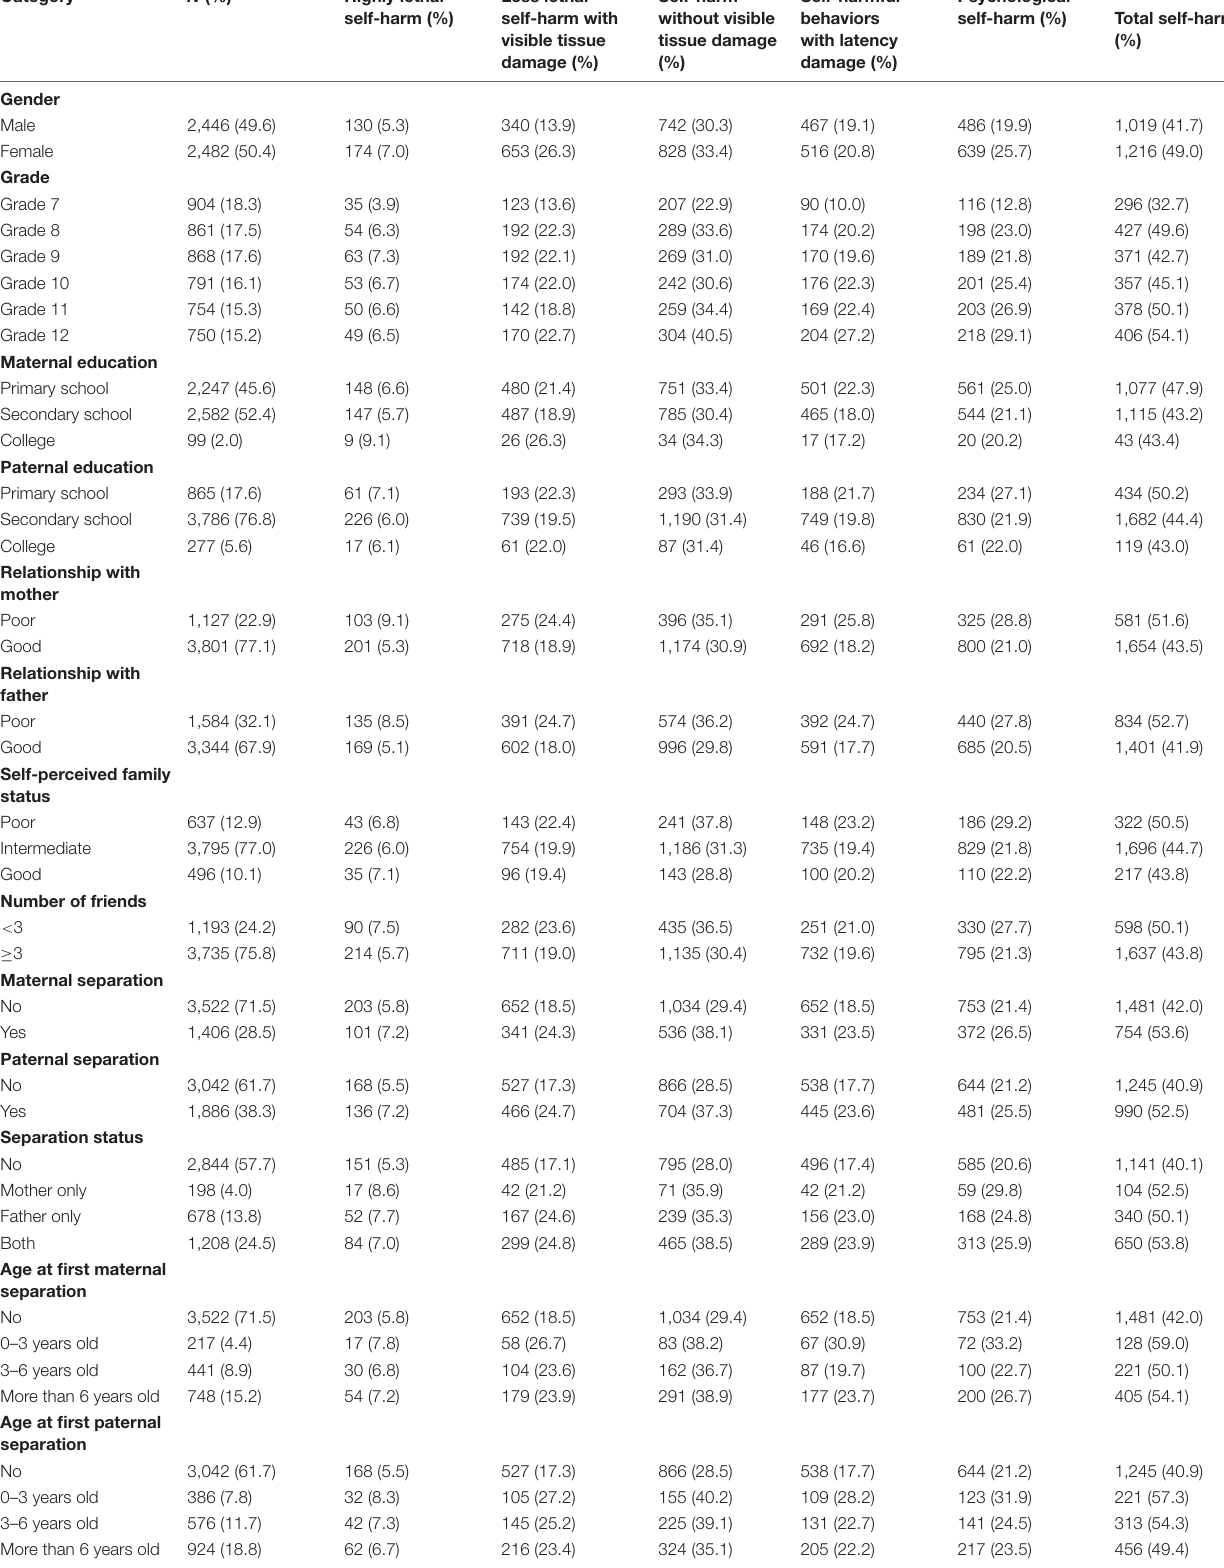
TABLE 1 | Prevalence of self-harm by sample characteristics ( N =